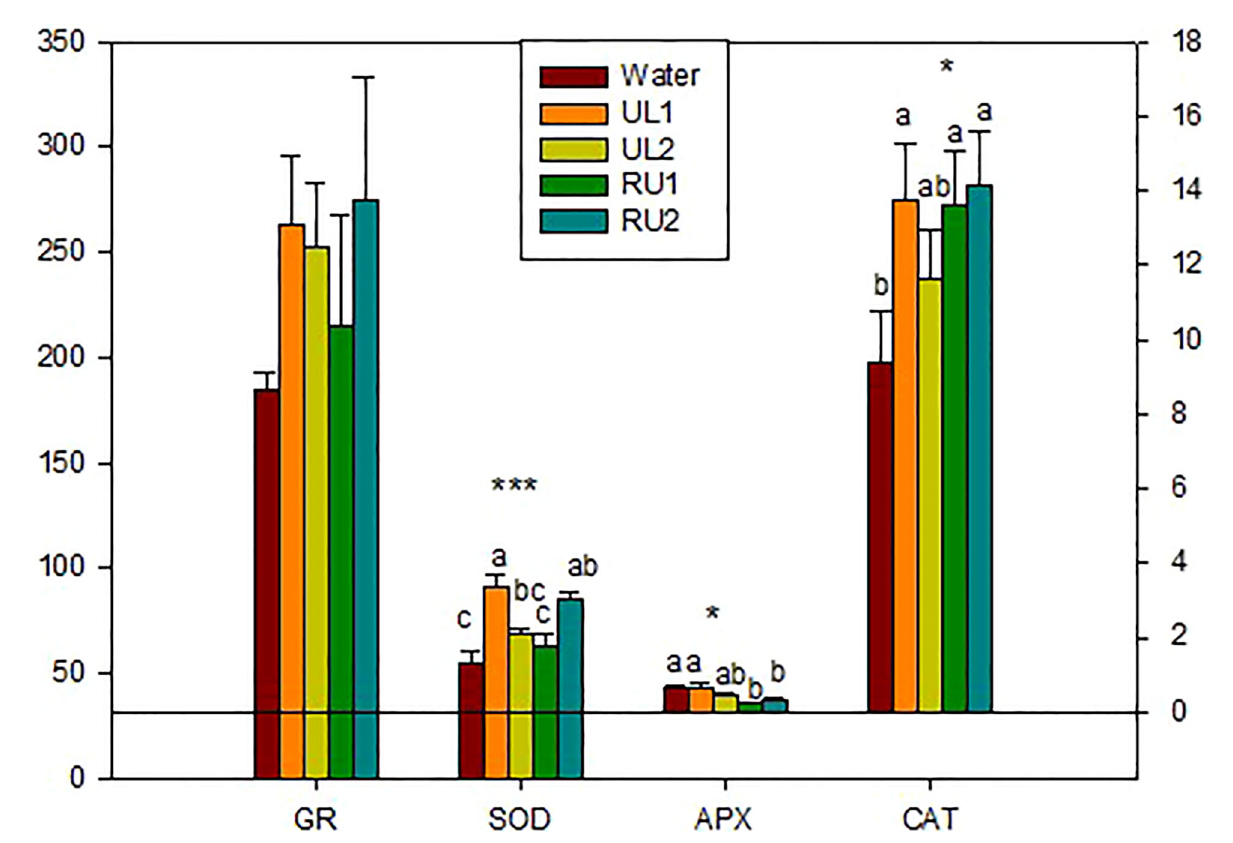
FIGURE 4 Enzymes related to plant defense at the end of the experiment. SOD, superoxide dismutase (U/mg protein); APX, ascorbate peroxidase (mmol Ascorbate/min mg protein); CAT, catalase (nmol H2O2/min mg protein); GR, gluthatione reductase (nmol NADPH/min mg protein). Analyses of variance. levels of signi fi cance (LS): *p < 0.05, ***p <